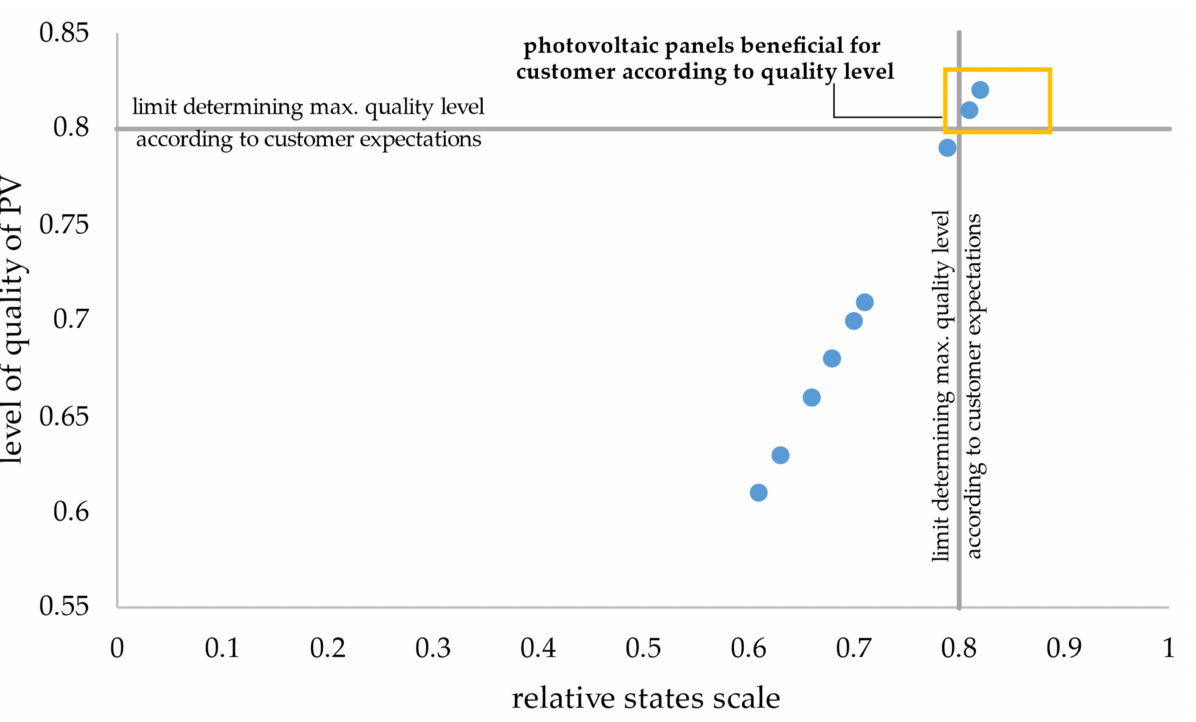
Figure 11. The choice of photovoltaic panels is favourable for customer according to the relative state scale. Own